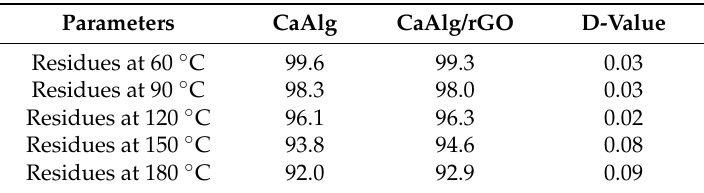
Table 1. Comparison of weight losses of Calcium alginate (CaAlg) and Calcium alginate/Reduced graphene oxide (CaAlg/rGO) materials under N 2 atmosphere before 200 ◦